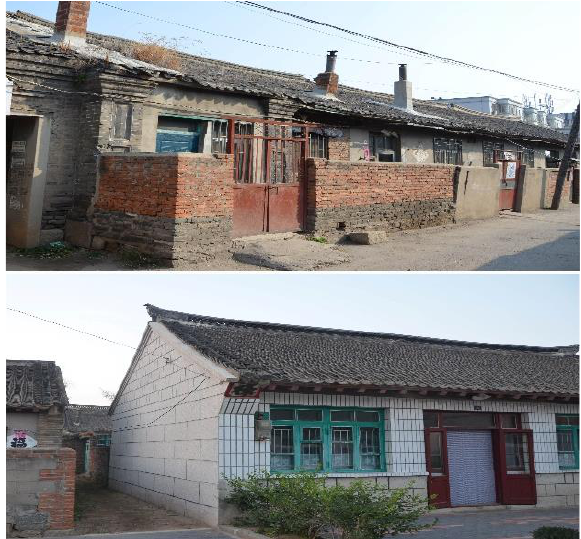
Figure 7. Traditional walls covered by modern materials.